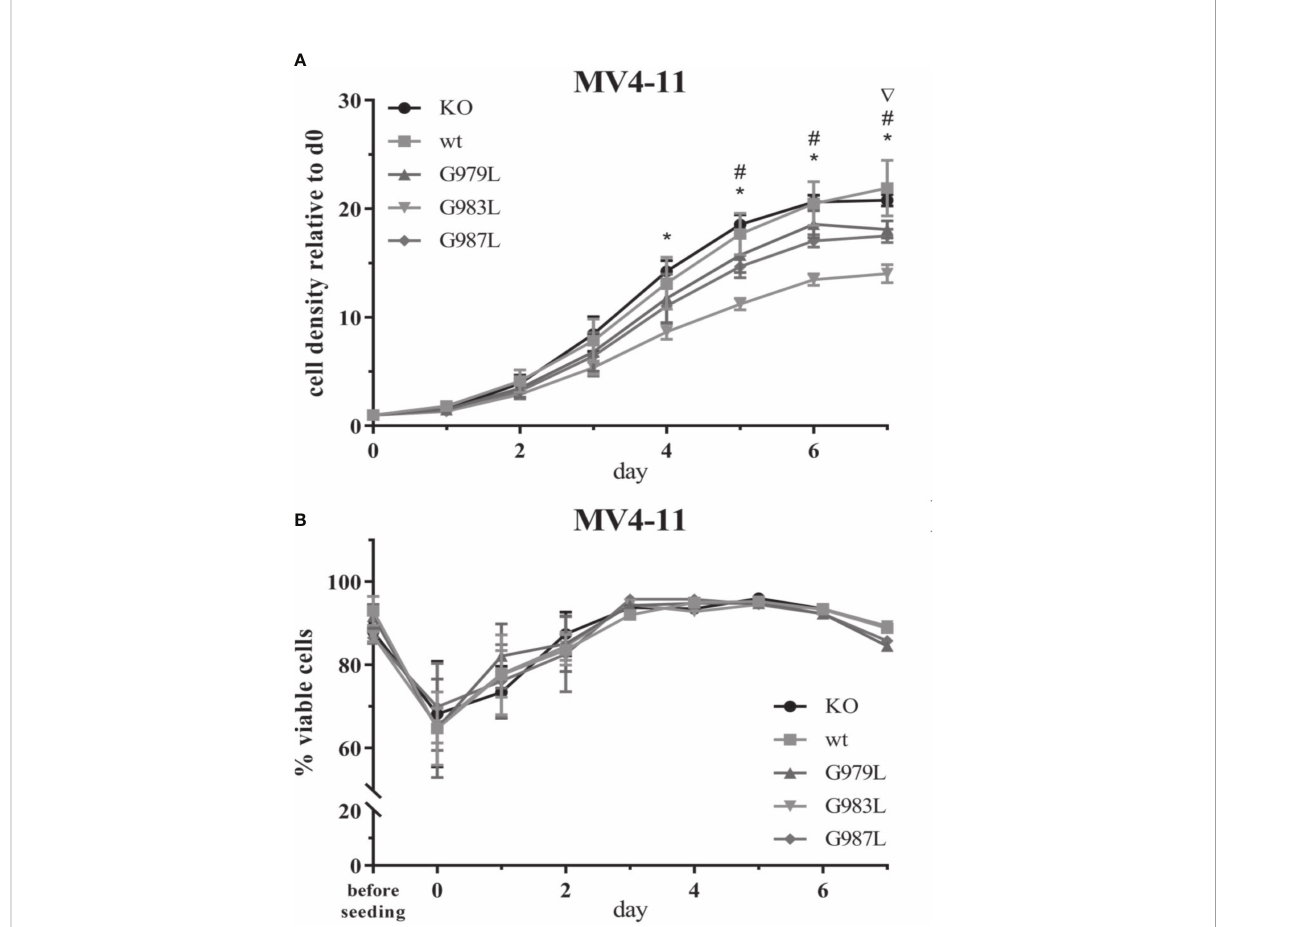
FIGURE 5 Proliferation and viability of MV4-11 cells expressing TMD mutant PTPRJ proteins. A+B) MV4-11 PTPRJ KO cells re-expressing wt PTPRJ or G- to-L mutants were seeded in duplicates in a 6-well plate. Cells were counted 4 hours after seeding (= day 0) and then every 24 hours for 7 days. (A) Cell density was determined by fl ow cytometry by measuring the number of viable cells in relation to the number of counting beads. The graphs show cell density relative to day 0. Values are given as mean ± standard deviation, n = 3. Statistics: repeated-measures two-way ANOVA and Dunnett ’ s multiple comparisons test; signi fi cant differences (p ≤ 0.05) of TMD mutants G979L ( ∇ ); G983L (*); and G987L (#) to wt PTPRJ are indicated. (B) Percentage of viable cells, measured by automated trypan blue count, is shown. Values are given as mean ± standard deviation, with n = 3 for d0 – 2 and n = 1 for d3 –